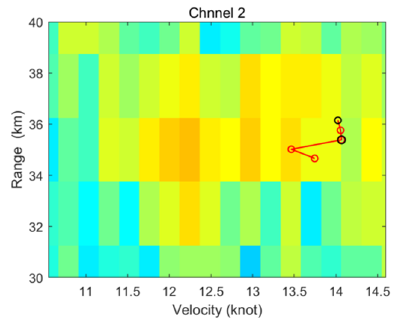
Figure 28. RD images of T1 during the period with uniform linear motion before P1. Figure 27. RD images of T1 during P1. Figure 27. RD images of T1 during P1. Figure 27. RD images of T1 during P1.